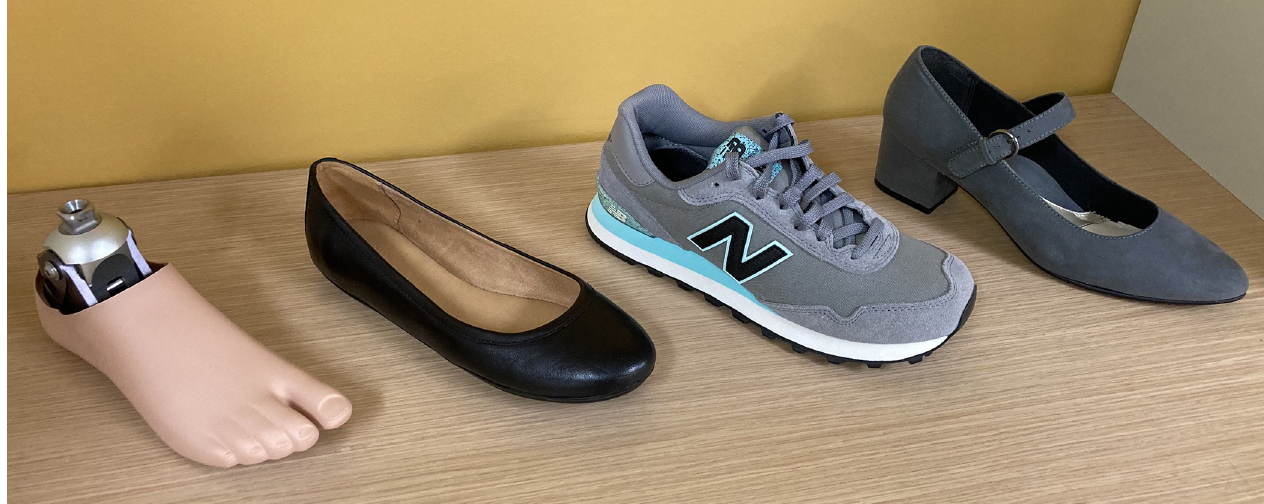
Fig 1. Four footwear conditions. Footwear heel height increases from left to right. Prosthesis and shoe images are similar but not identical to the original images and are therefore for illustrative purposes only.